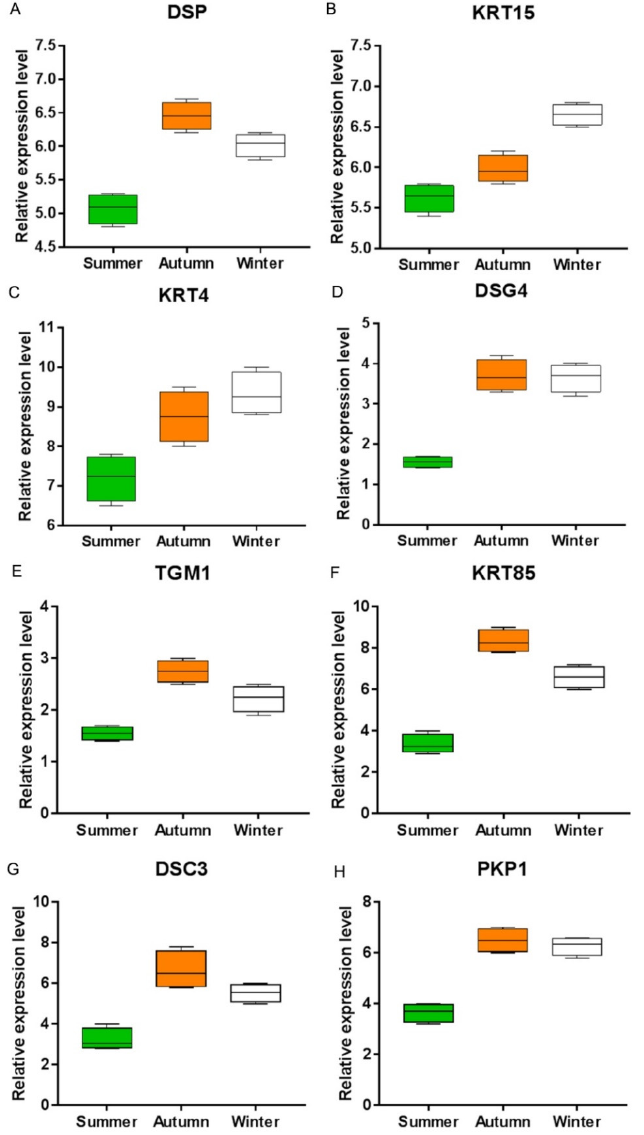
Figure 7. Expression levels of eight genes in the summer, autumn, and winter groups: ( A ) DSP gene; ( B ) KRT15 gene; ( C ) KRT4 gene; ( D ) DSG4 gene; ( E ) TGM1 gene; ( F ) KRT85 gene; ( G ) DSC3 gene; ( H ) PKP1 gene. All of the data are shown as the mean ±